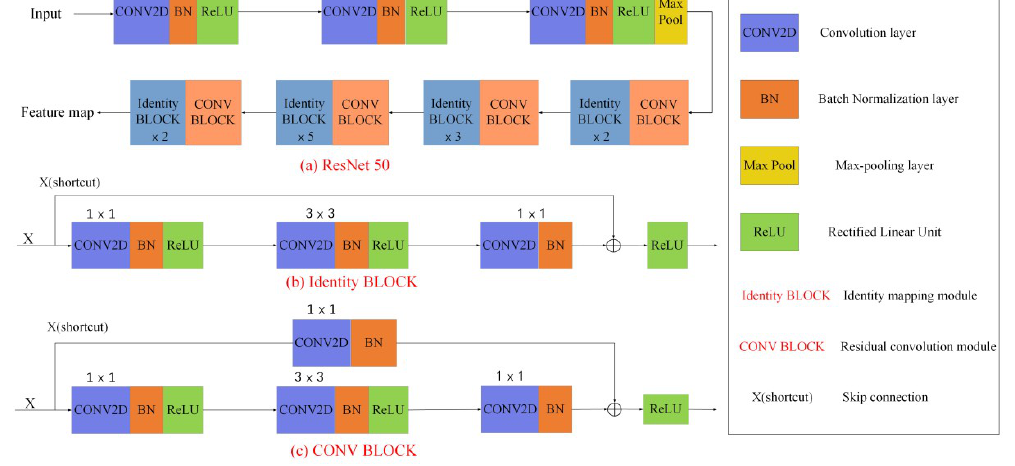
Figure 3. Structure of the feature extraction network (ResNet50).